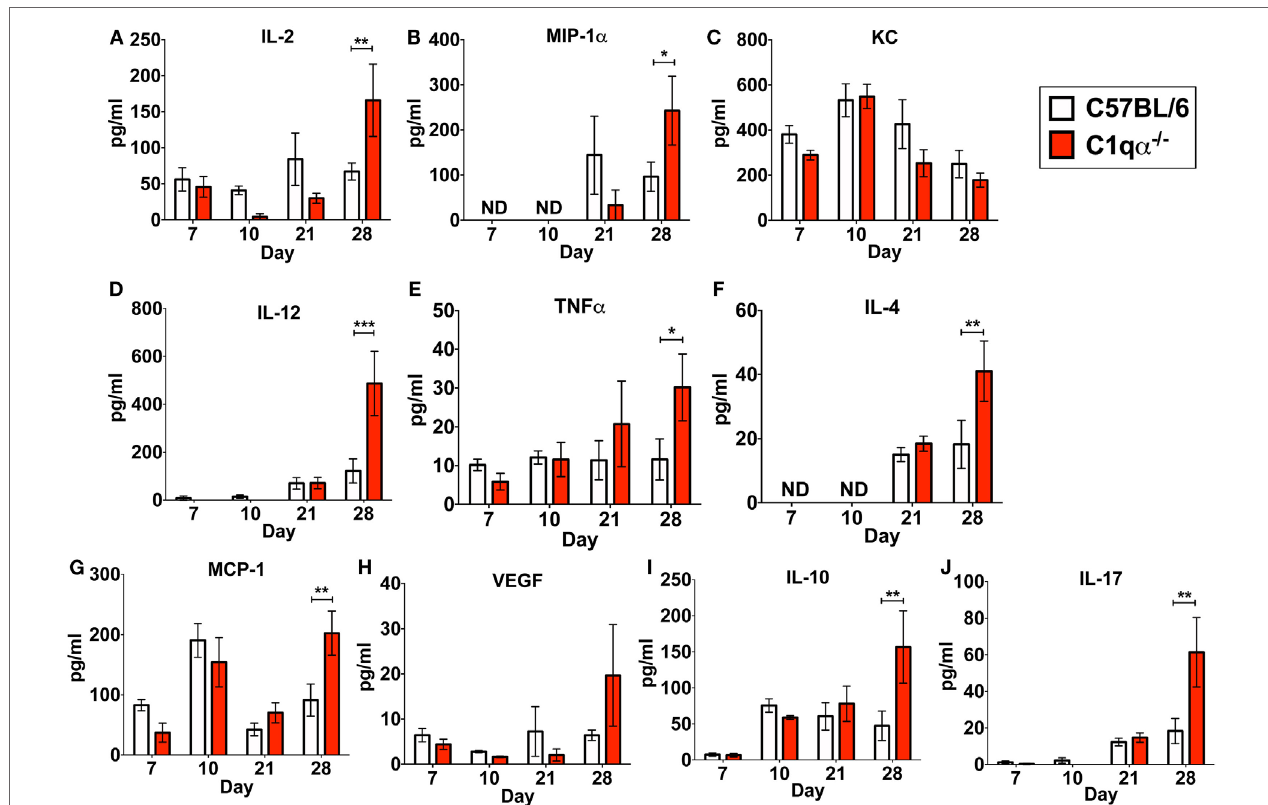
FigUre 4 | C1q deficiency affects the level of circulating cytokines in infected mice. Whole blood was collected from mice infected with 10 4 Borrelia burgdorferi strain MSK5 (24) at 7, 10, 21, and 28 days post-infection. Serum was isolated by centrifugation, and the level of 10 circulating cytokines (a–J) was determined using the Bio-Plex system employing the Luminex multianalyte profiling technology. The white column represents C57BL/6 mice, whereas the red column refers to data associated with C1q α − / − mice; n = 4–5 for samples from days 7, 10, and 21; n = 10 for samples from day 28. Abbreviation: ND, not detected (* P < 0.05; ** P < 0.01; and *** P <